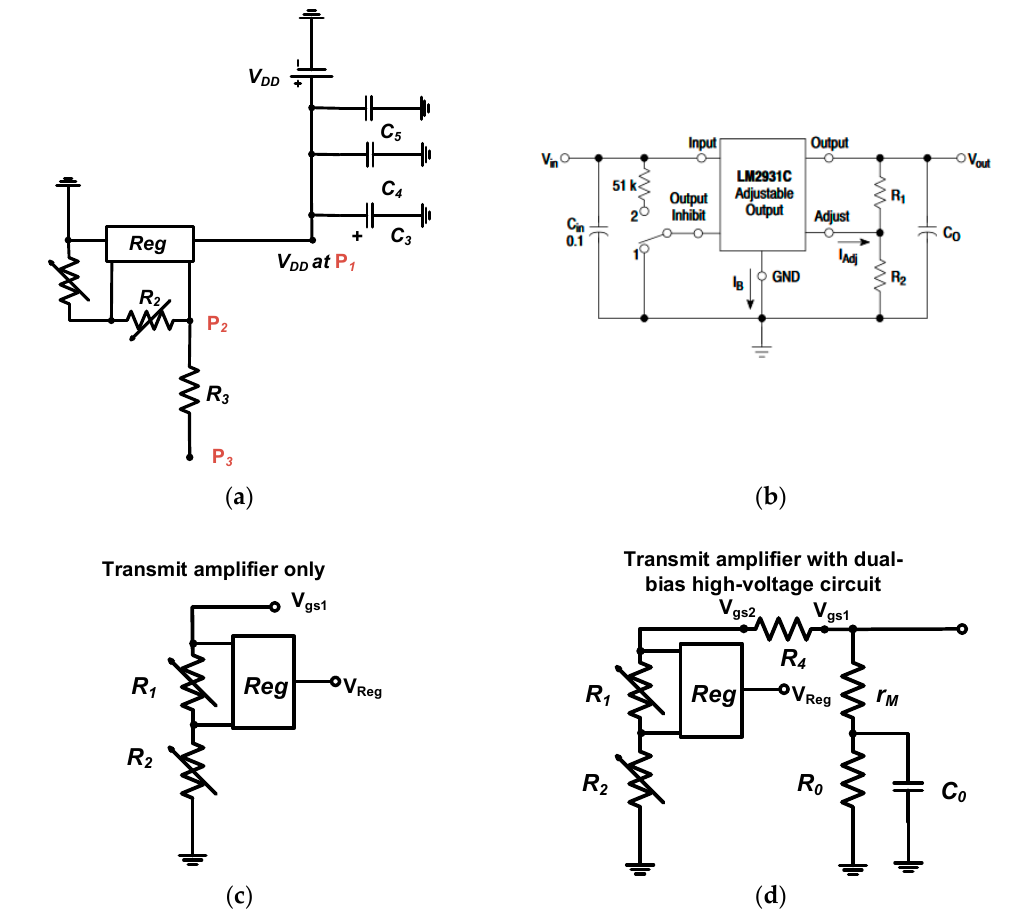
Figure 4. ( a ) Schematic diagram of gate-source voltage of the transmit amplifier and ( b ) voltage regulator (LM2931C); Equivalent circuit models of gate-source DC bias voltage of ( c ) transmit amplifier only ( d ) and transmit amplifier with dual-bias high-voltage circuit.